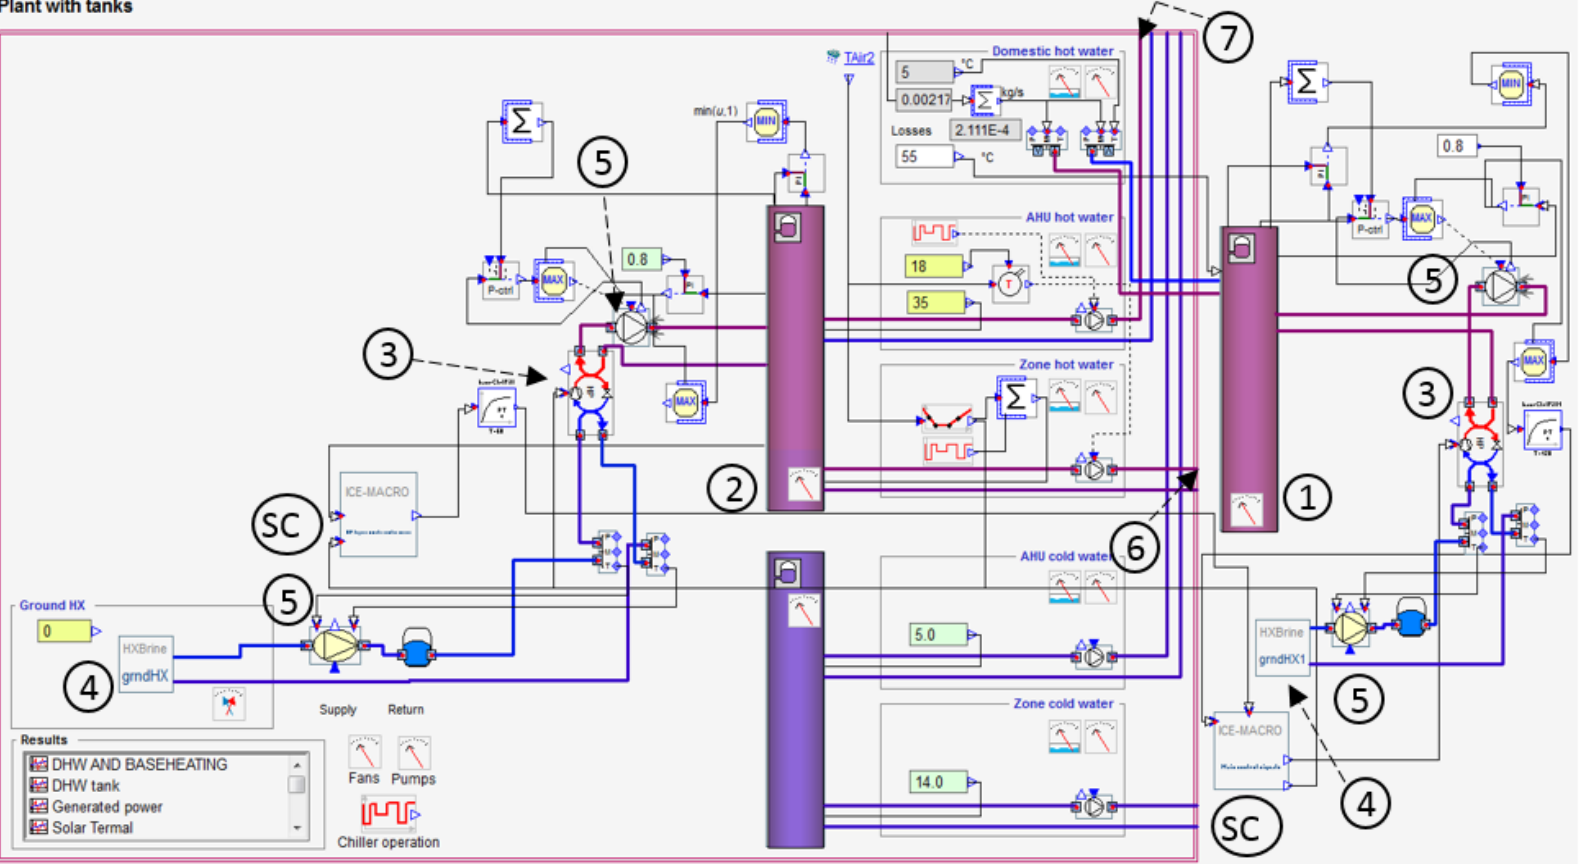
Figure 7. Implemented in the plant model.